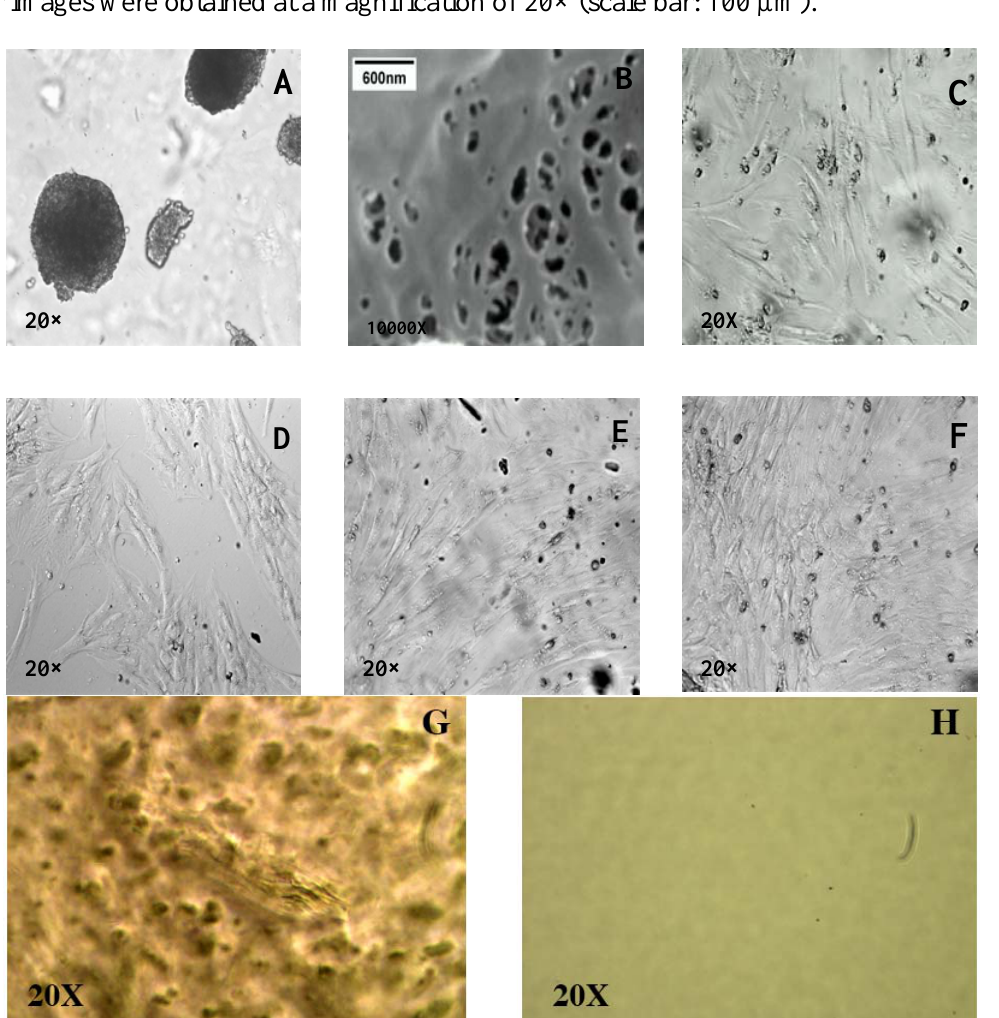
Figure 5. ( A ). Bright-field microscopic image ASCs grown on MC hydrogel system (with no collagen coating) for 1 day; ( B ). A Scanning Electron Microscope, SEM (JEOL 840A SEM operated at an accelerating voltage of 20 kV) image of the collagen network formed onto the MC coated TCPS dish; ( C ). Bright-field microscopic image of ASCs grown on MC hydrogel system coated with collagen for 1 day; ( D ): Bright-field microscopic image of cells attached and grown on a non-coated TCPS dish (control) for 1 day. The ASC were completely unreceptive to the hydrogel surface without collagen coating and generated embryoid-like structures (Figure 5A). The addition (evenly spread) of 200 µL of 2 mg/mL bovine collagen type -I (pH adjusted to 7.5) over the MC coated surface at 37 °C (Figure 5B), significantly improved the ASC cell adhesion on the hydrogel system (Figure 5C).